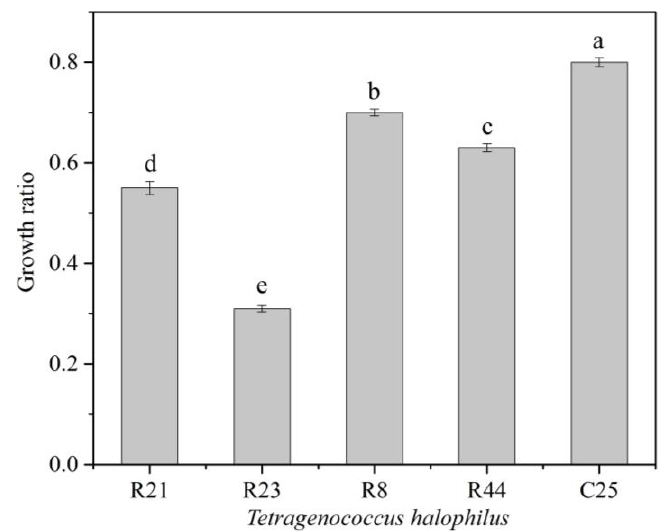
Figure 1. Growth of T. halophilus strains under aerobic and anaerobic conditions. Growth ratio: the growth rate of T. halophilus strains cultivated anaerobically divided by that cultivated aerobically. Different lowercase letters indicate significant differences among individual groups ( p < 0.05).